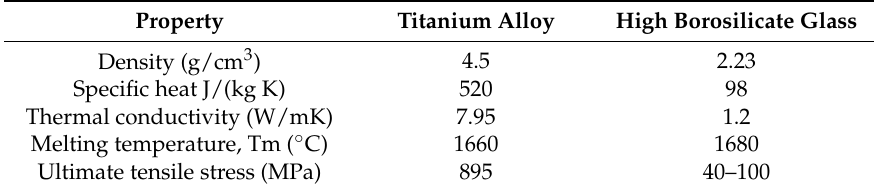
Table 1. Main properties of titanium alloy and high borosilicate